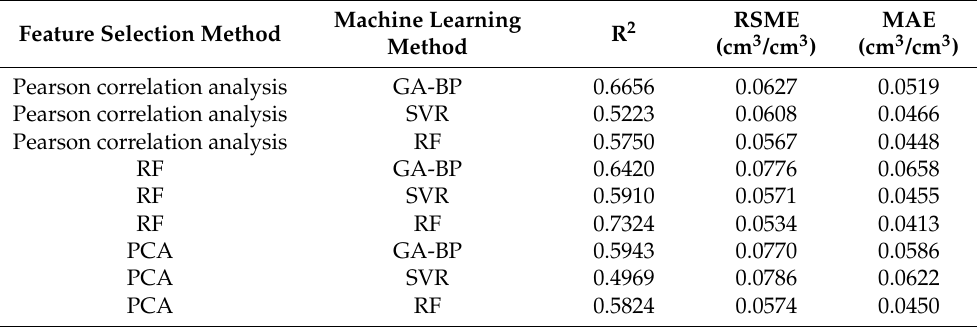
Table 6. Comparison of the accuracy of the inversion results under different model